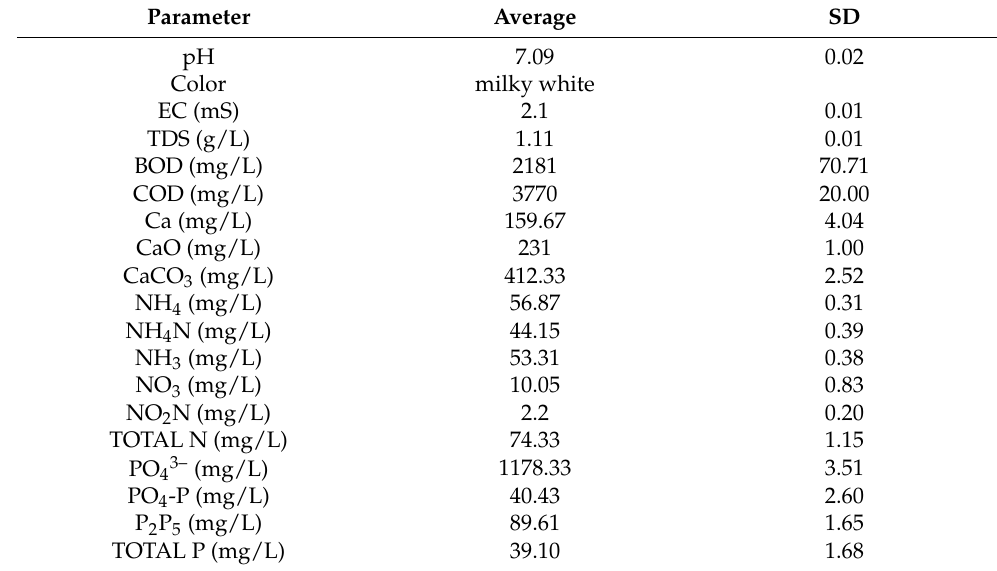
Table 4. Physico-chemical characteristics of real industrial dairy